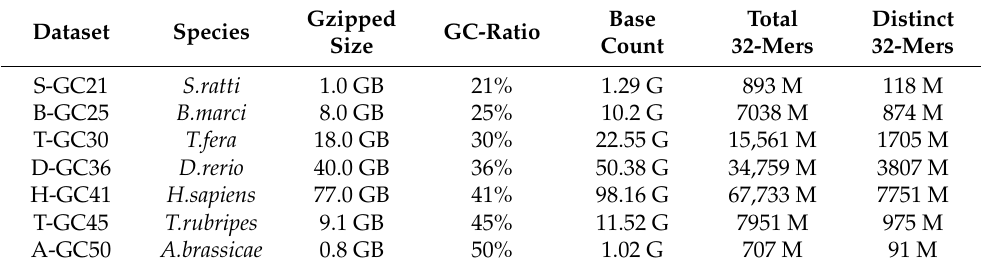
Table 1. Simulated datasets of various GC-content (Coverage: 30X, Q30: 90.66%).